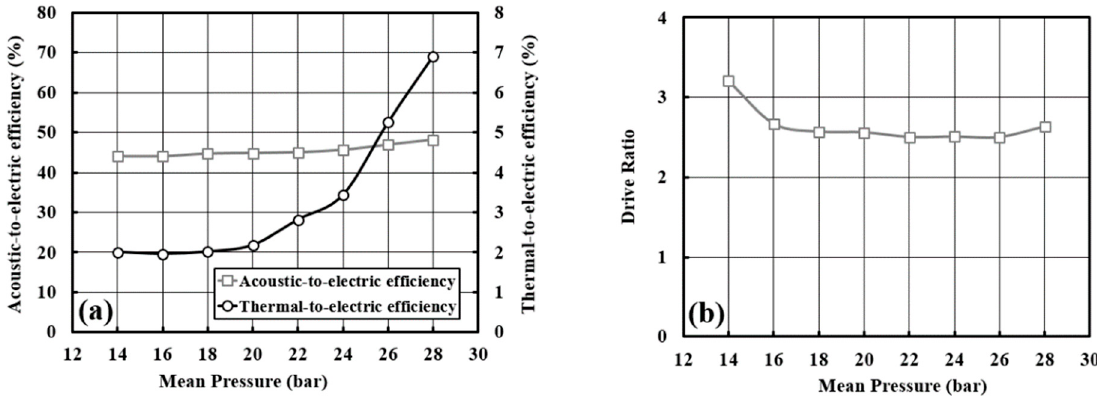
Figure 8. (a) Acoustic-to-electric and thermal-to-electric efficiencies vs. mean pressure; (b) Drive ratio vs. mean pressure. Heating power is 900 W.